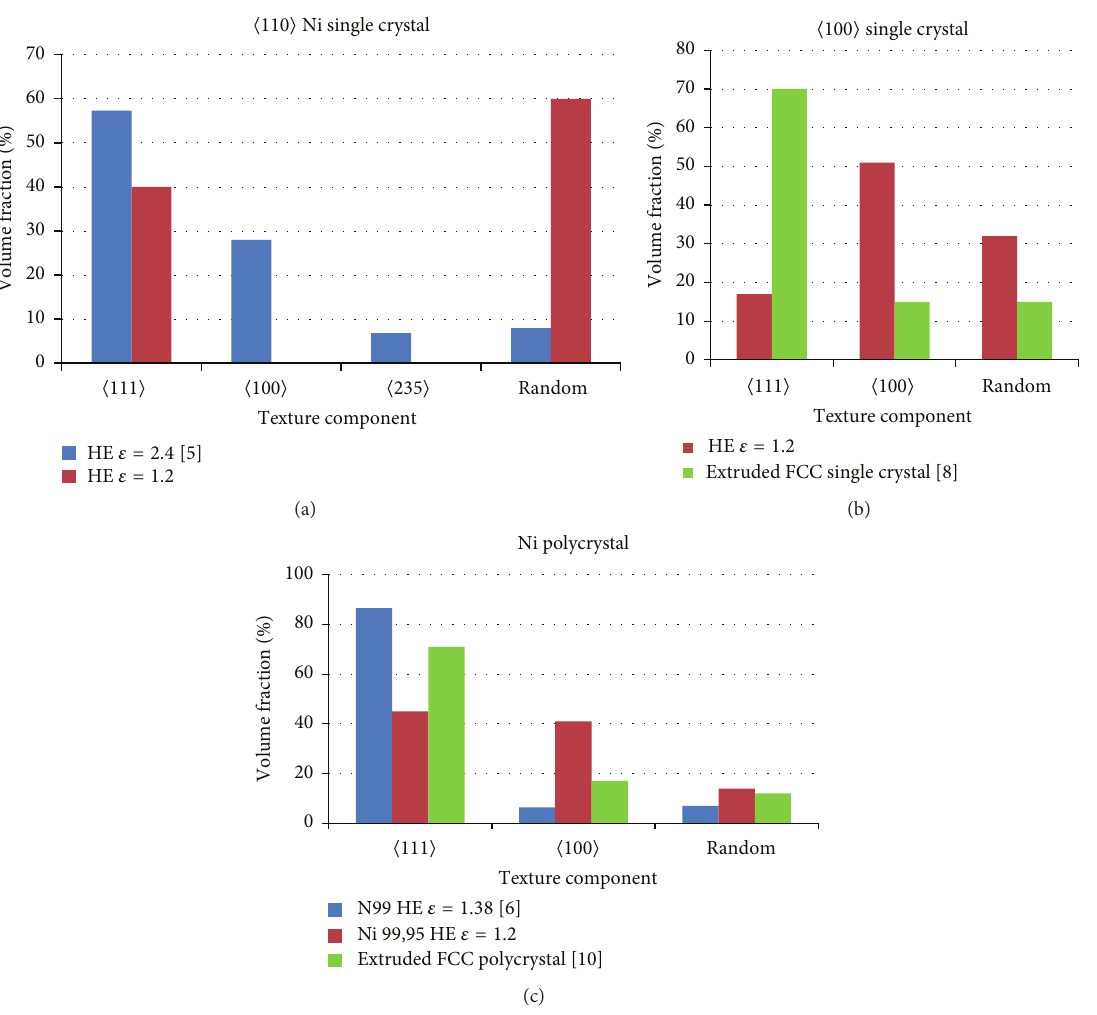
Figure 6: Quantitative texture analysis of single crystals (a) and (b) and polycrystals (c) [5, 6,